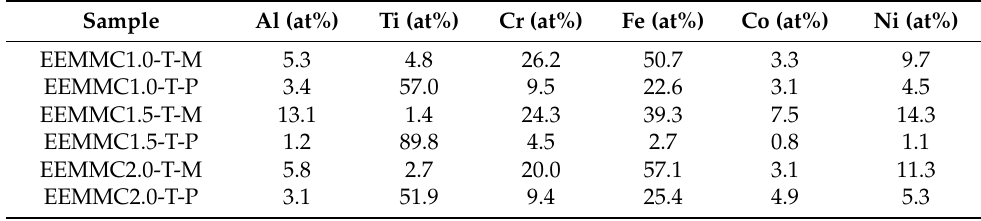
Table 3. EDS point analysis data (average of 5